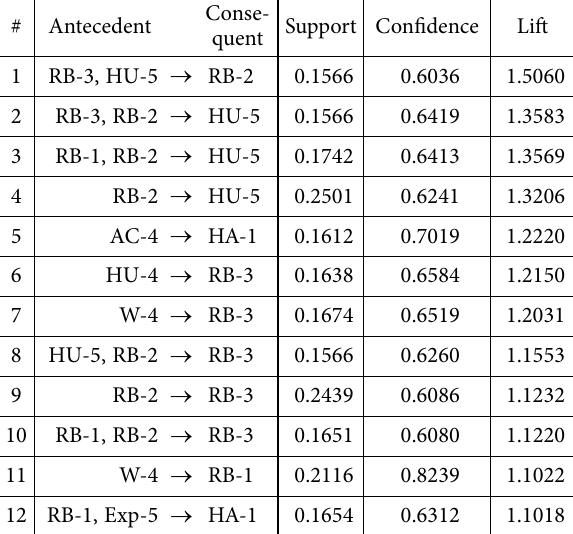
Figure 6. Scatter plot of 202 rules